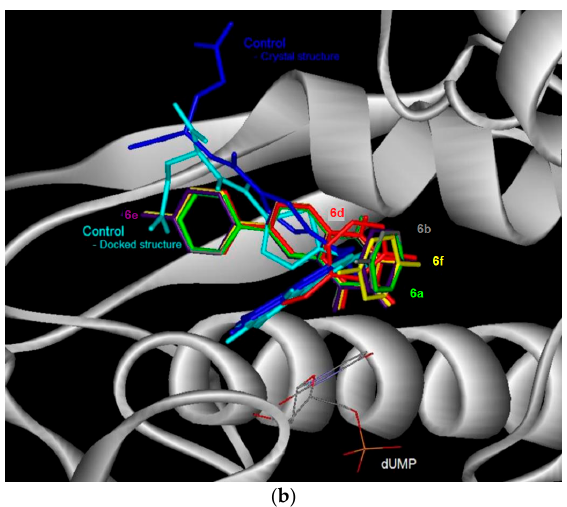
Figure 3. The binding conformation in human thymidylate synthase (TS) for the 6-bromoquinazolinones ( a ) and their 6-aryl substituted derivatives ( b ).